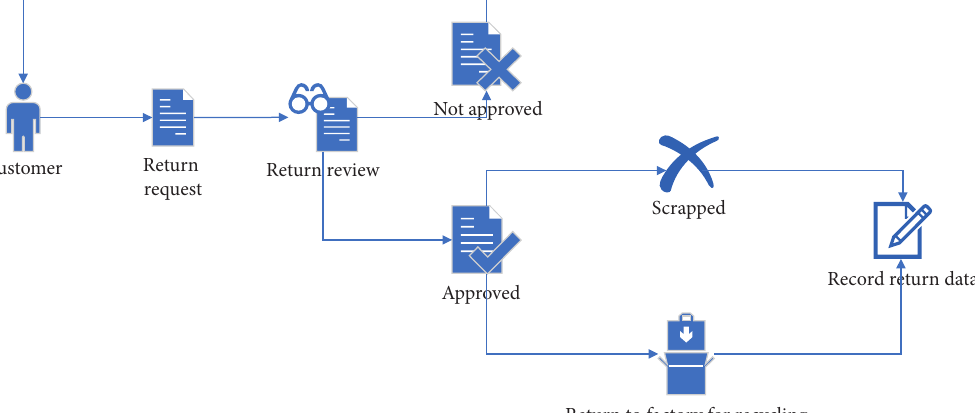
Figure 10: Return management